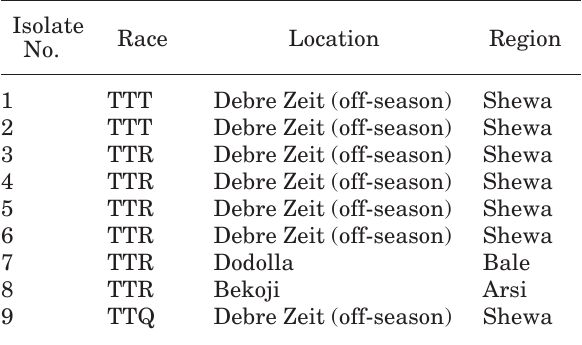
Table 3. Races of Puccinia graminis f. sp. tritici in the Arsi, Bale, Gojjam and Gondar regions of Ethiopia in 2003. Isolate No.